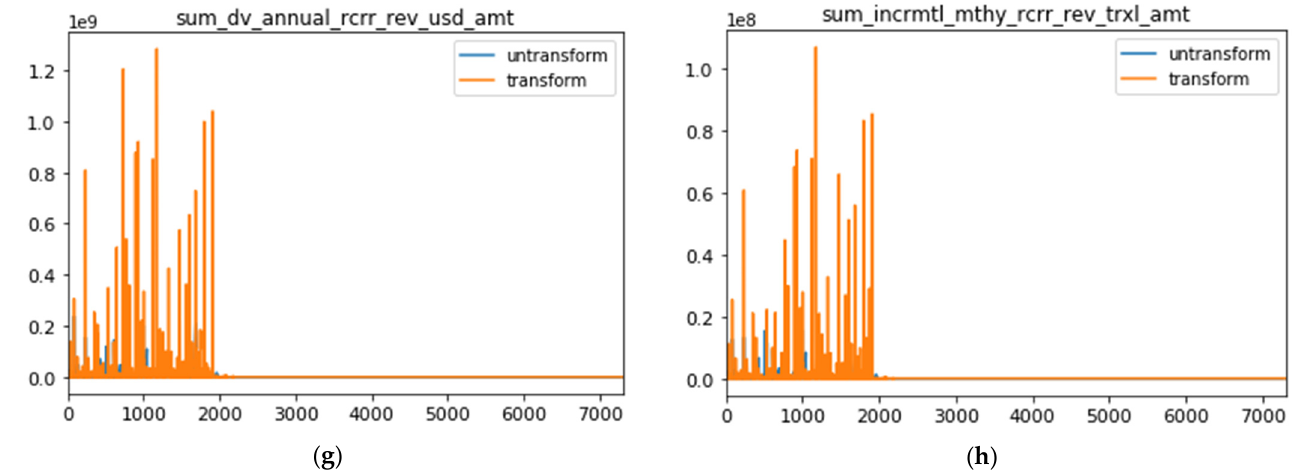
Figure 7. ( a ) Comparing rebate booking attribute with two partner types; ( b ) Comparing annualized booking attribute with two partner types; ( c ) Comparing actual booking attribute with two partner types; ( d ) Comparing list price booking attribute with two partner types; ( d ) Comparing list price booking attribute with two partner types; ( e ) Comparing nonrecurring revenue attribute with two partner types; ( f ) Comparing confirm booking attribute with two partner types; ( g ) Comparing annual recurrence attribute with two partner types; ( h ) Comparing monthly recurrence reveue attribute with two partner